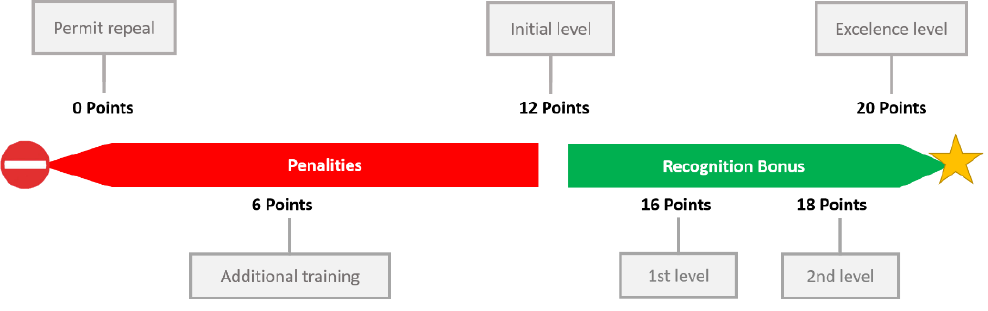
Figure 3 . SSP System – scoring